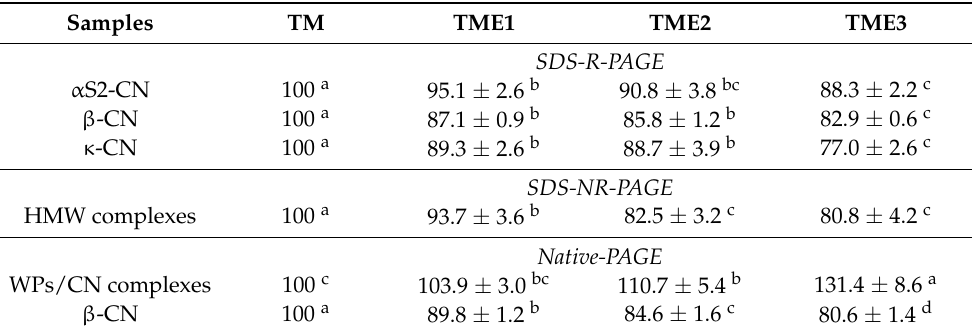
Table 3. The change (%) of caseins and HMW complexes content in TME samples in relation to the same band in TM sample, determined by different electrophoretic techniques. Samples TM TME1 TME2 TME3 SDS-R-PAGE α S2-CN 100 a 95.1 ± 2.6 b 90.8 ± 3.8 bc 88.3 ± 2.2 c β -CN 100 a 87.1 ± 0.9 b 85.8 ± 1.2 b 82.9 ± 0.6 c κ -CN 100 a 89.3 ± 2.6 b 88.7 ± 3.9 b 77.0 ± 2.6 c SDS-NR-PAGE HMW complexes 100 a 93.7 ± 3.6 b 82.5 ± 3.2 c 80.8 ± 4.2 c Native-PAGE WPs/CN complexes 100 c 103.9 ± 3.0 bc 110.7 ± 5.4 b 131.4 ± 8.6 a β -CN 100 a 89.8 ± 1.2 b 84.6 ± 1.6 c 80.6 ± 1.4 d Values are presented as mean values ± standard deviations ( n = 3). Different letters in the same order denote a significant difference according to t -test, p < 0.05. Abbreviations: Skimmed thermally treated goat’s milk powder (TM); Skimmed thermally treated goat’s milk/seed extract powder (0.2 mgTPC/mL) (TME1); Skimmed thermally treated goat’s milk/seed extract powder (0.4 mgTPC/mL) (TME2); Skimmed thermally treated goat’s milk/seed extract powder (0.6 mgTPC/mL)